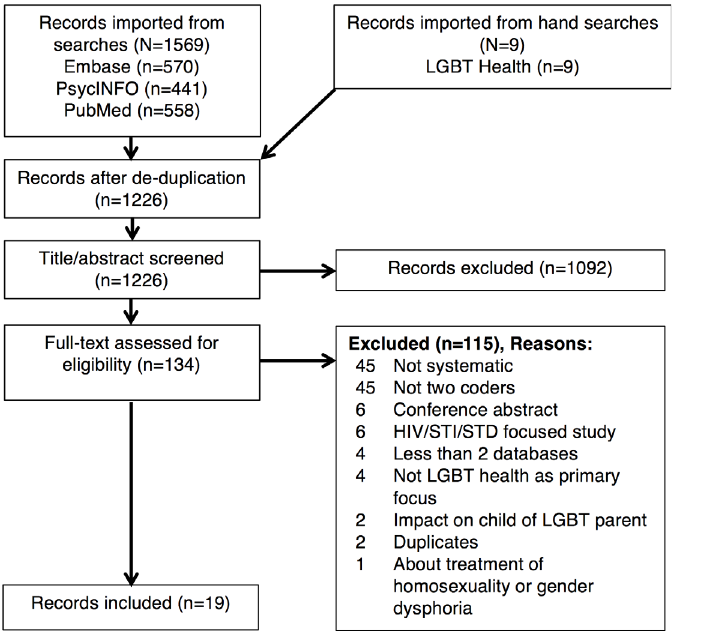
Fig 1. PRISMA Flow Diagram, May 28 – 29,